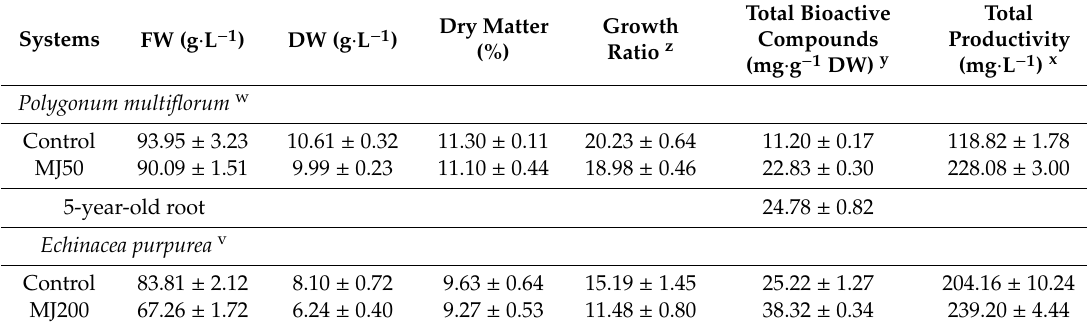
Table 2. Effect of MJ on the accumulation of biomass and secondary metabolites in Polygonum multiflorum and Echinacea purpurea adventitious root culture